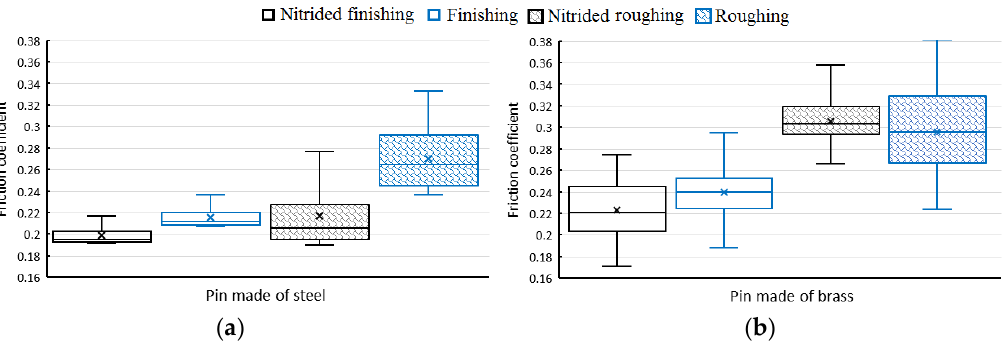
Figure 4. Boxplots of the friction coefficients at the stationary phase for the different surface conditions with and without the nitriding treatment for ( a ) pins made of steel and ( b ) pins made of brass. Regarding the pins made of brass, the friction coefficient shows no significant changes with and without the plasma nitriding treatment. However, as expected, the lower friction coefficient corresponds to the specimens processed by finishing EDM compared to roughing EDM. On the